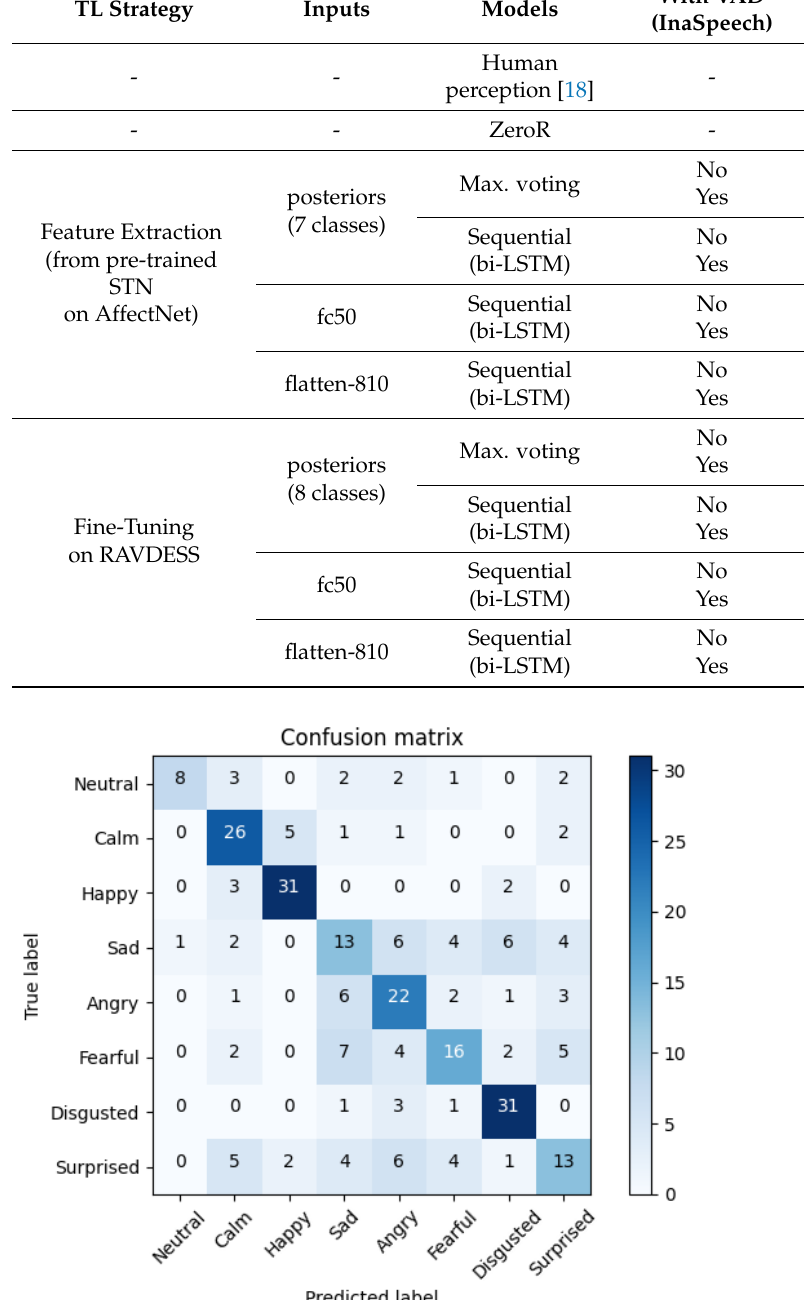
Figure 6. Average confusion matrix of the bi-LSTM with two layers of 300 neurons and two attention layers trained with the embeddings extracted from the flattened-810 of the fine-tuned STN. Accuracy of 57.08%. See Table